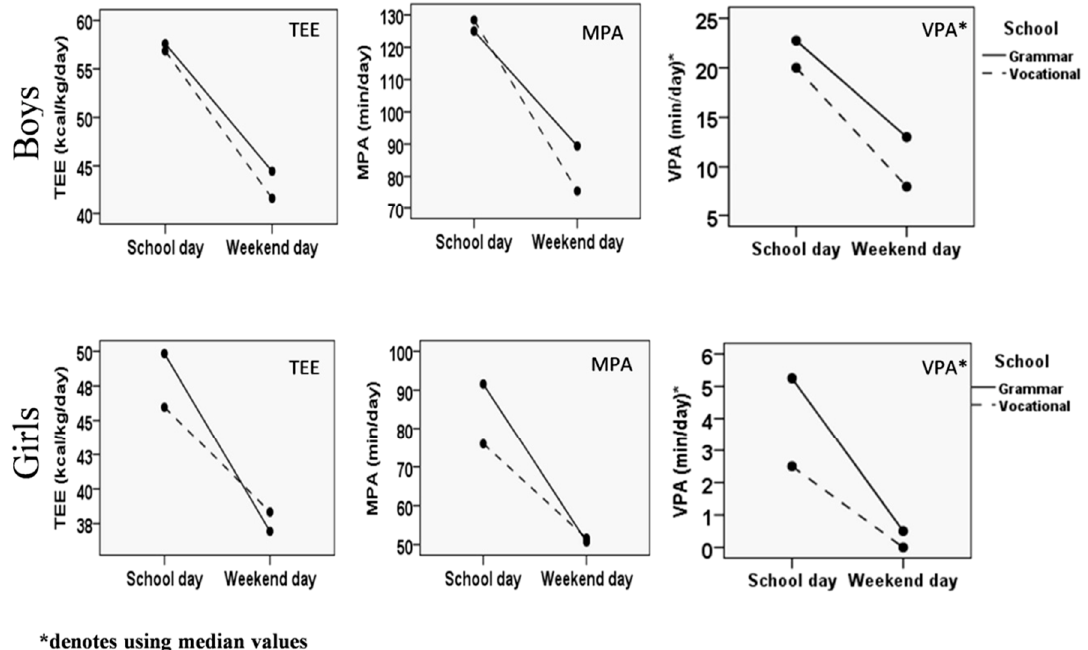
Figure 1. Changes in total energy expenditure (TEE), moderate physical activity (MPA) and vigorous physical activity (VPA) between school days and weekends in boys and girls attending grammar or vocational schools.